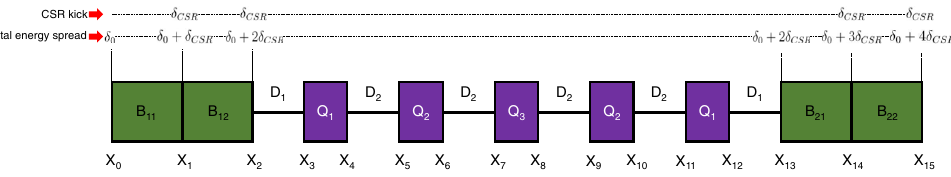
FIG. 11. Achromatic dog-leg transfer line lattice for calculating the emittance growth with both the higher-order terms and CSR effect. D 1 and D 2 are the elements of the drift space, and Q 1 , Q 2 , and Q 3 are the quadrupole magnets. B 11 and B 12 are slices of the first sector bending dipole magnet, and B 21 and B 22 are slices of the second sector bending dipole magnet.